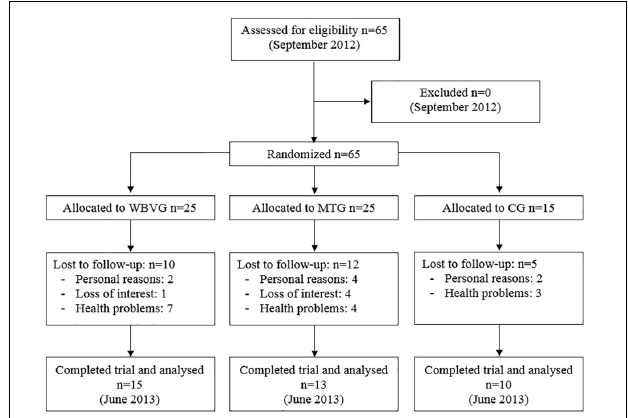
FIGURE 1 | Trial profile. WBVG, whole-body vibration group; MTG, multi-component training group; CG, control